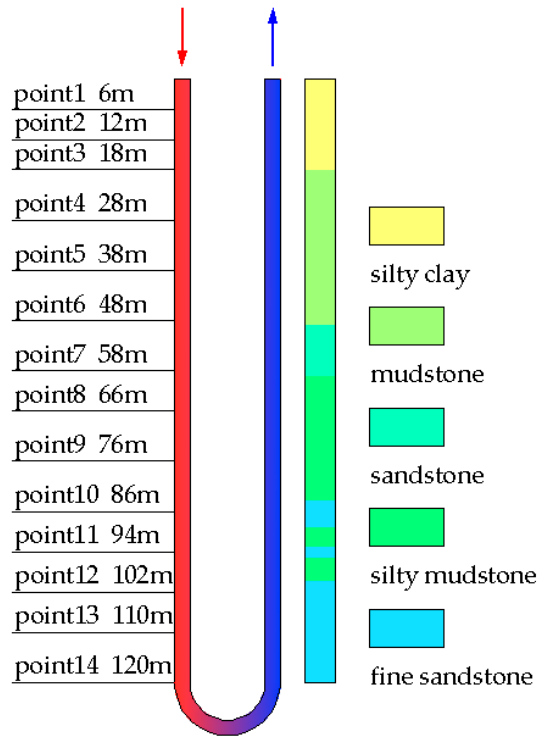
Figure 5. Schematic measurement setup diagram of the DTRT.